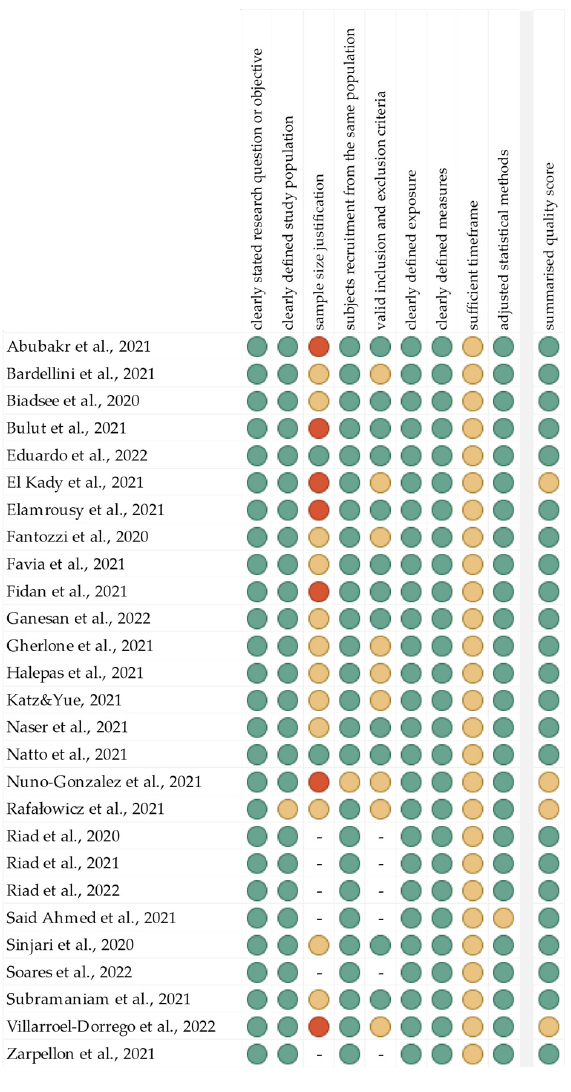
Figure 1. Quality assessment, including the main potential risk of bias. (Risk level: green—low; yellow—unspecified; red—high. Quality score: green—good; yellow—intermediate; red—poor).